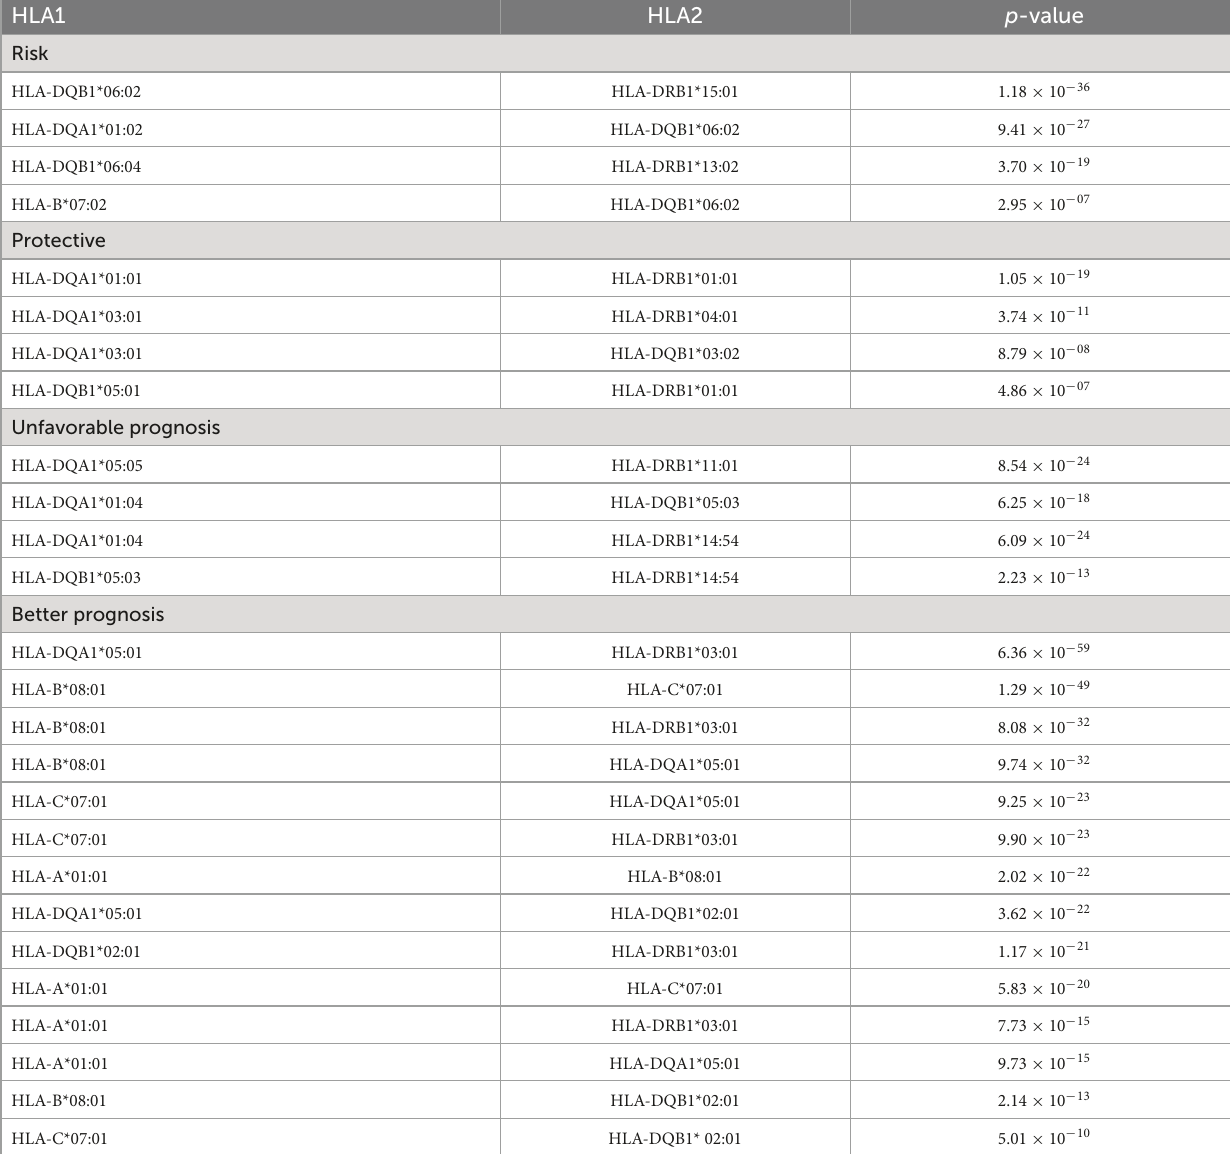
TABLE 7 Linkage disequilibrium between HLA alleles observed to be associated with sarcoidosis in Czech population among variants being susceptible for sarcoidosis, protective for sarcoidosis, associated with unfavorable prognosis and associated with better prognosis in sarcoidosis. HLA1 HLA2 p